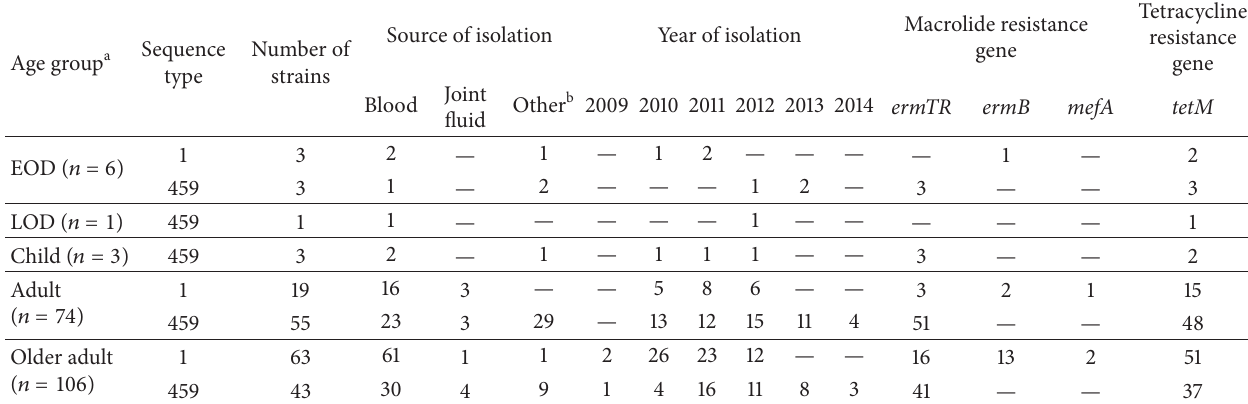
Table 1: Clonal complex 1 group B Streptococcus strains used in this study.